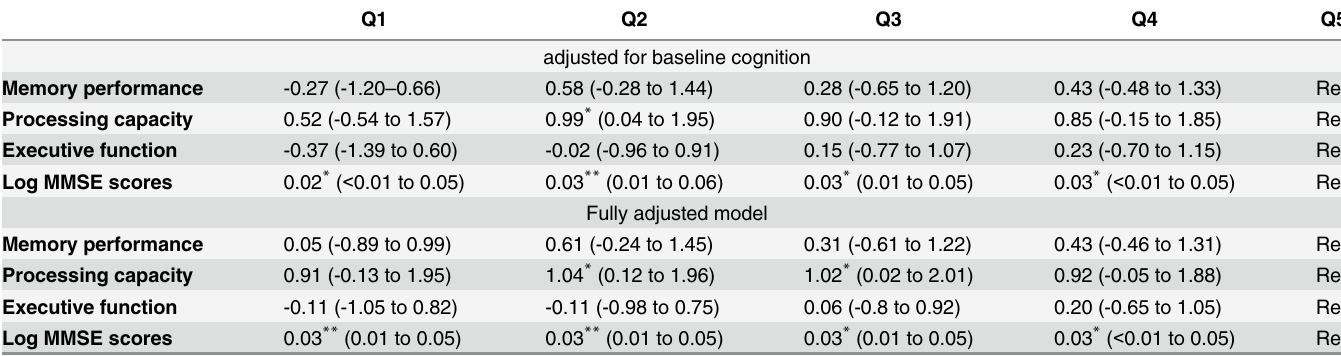
Table 3. B (95% CI) for association between cognitive scores at follow-up and quintiles of